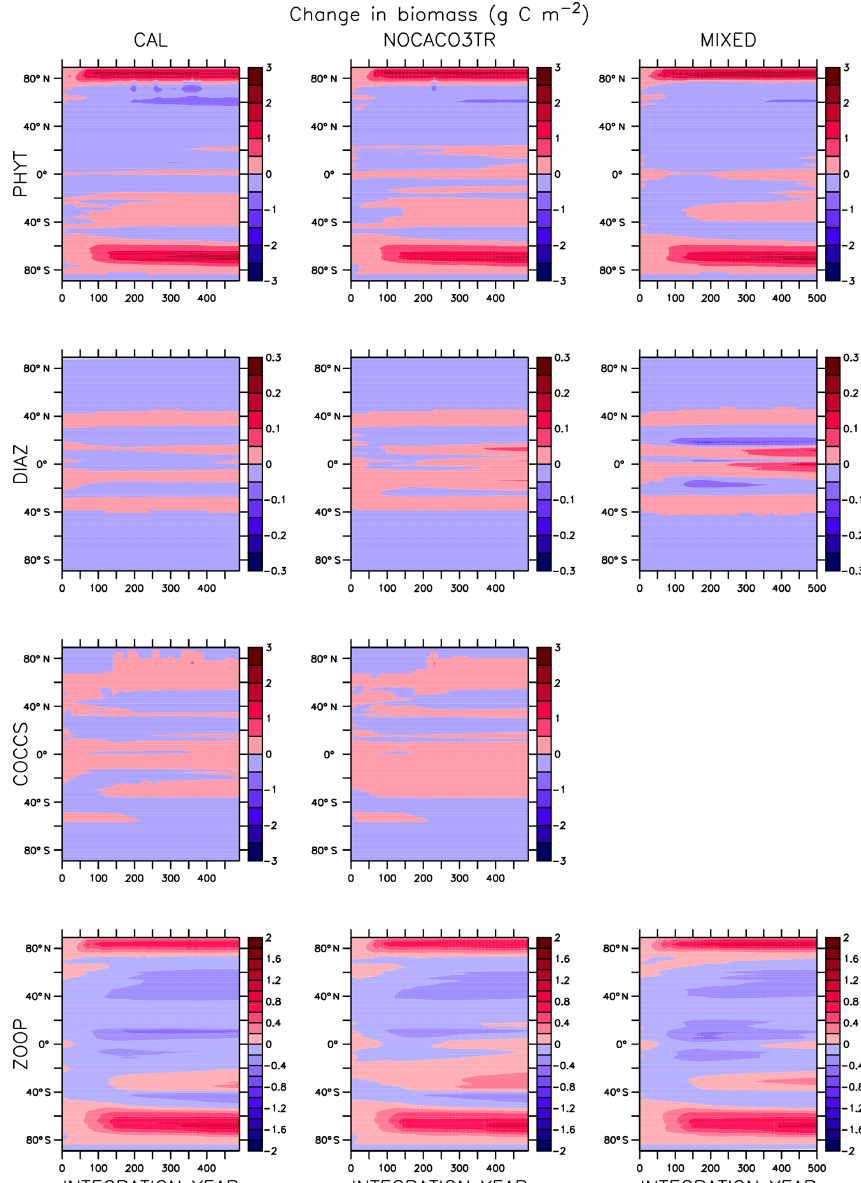
Figure A2. Zonally averaged changes in plankton biomass over the WARMING simulation.